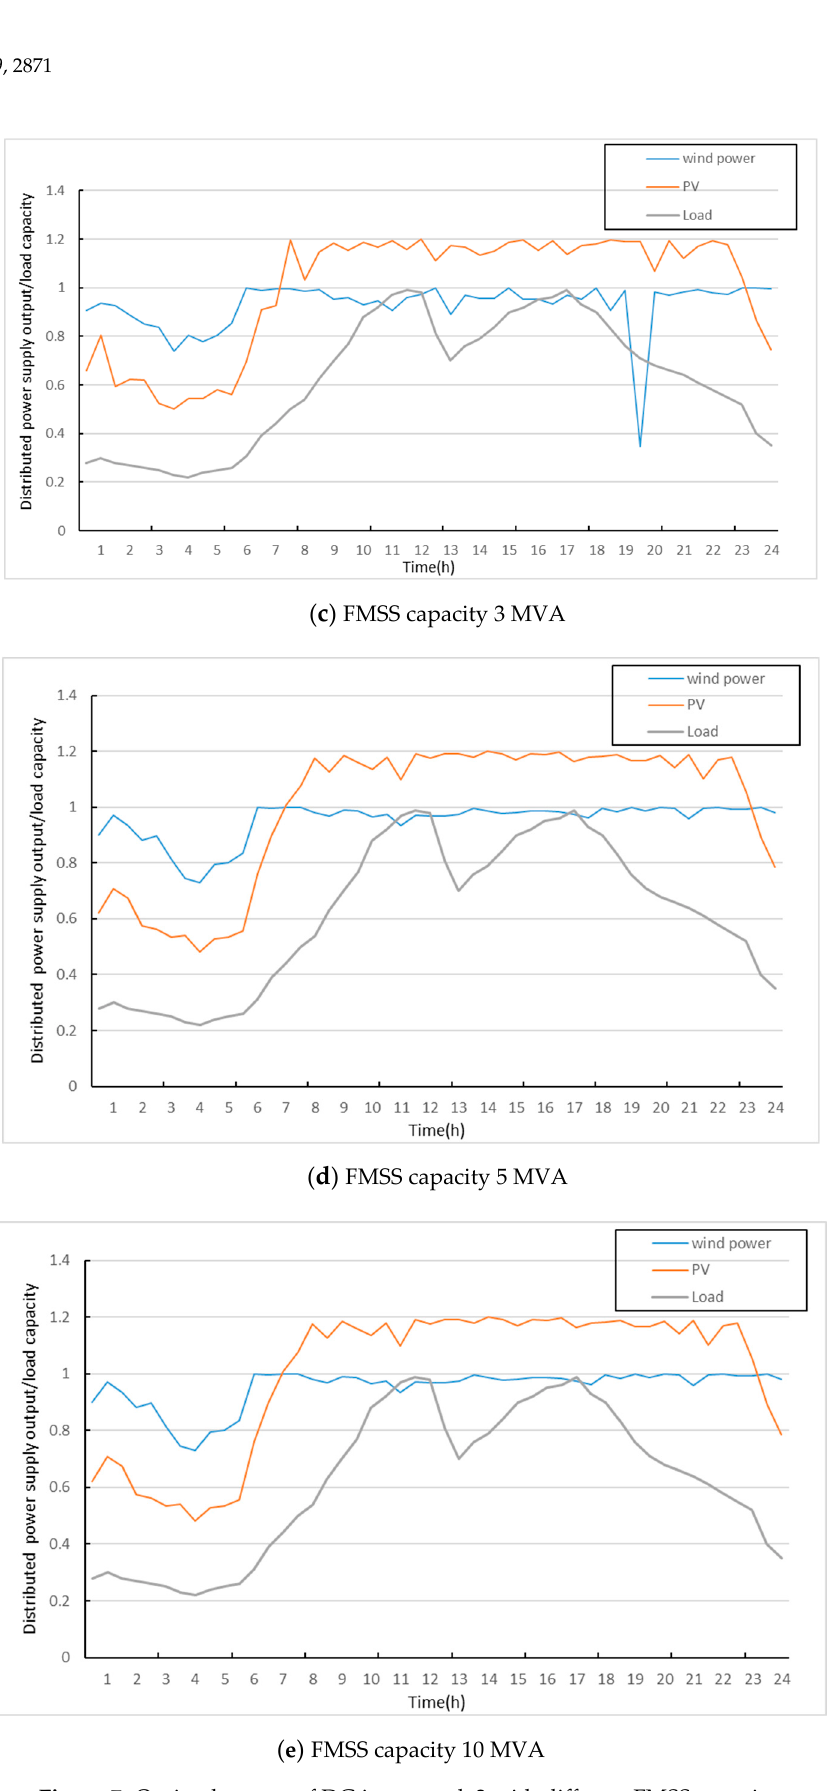
Figure 7. Optimal output of DG in network 2 with different FMSS capacity.